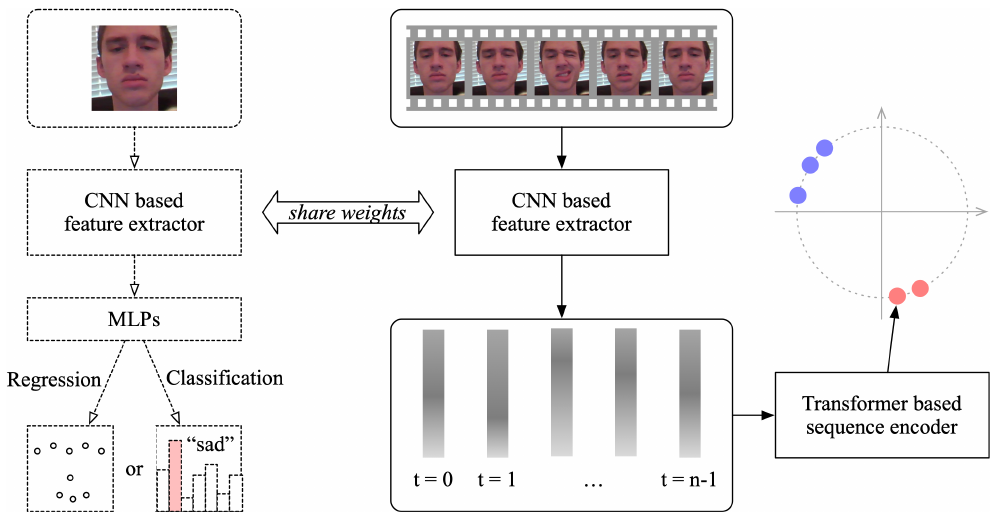
Figure 2. Network